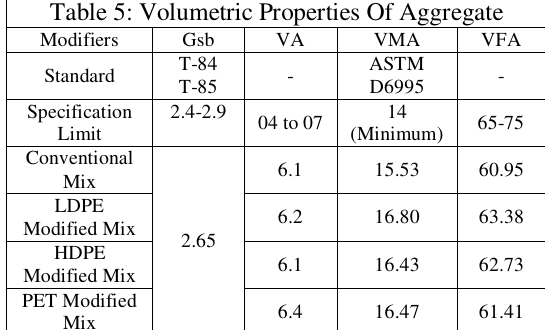
Table 5: Volumetric Properties Of